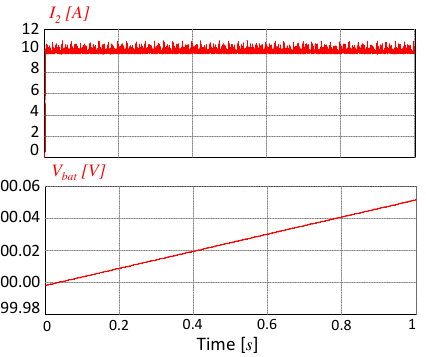
Figure 20. Charge of the battery from the grid: Current through the inductor L 2 , I 2 ; voltage in the battery V bat ; current in the grid I grid and the voltage in the grid V grid